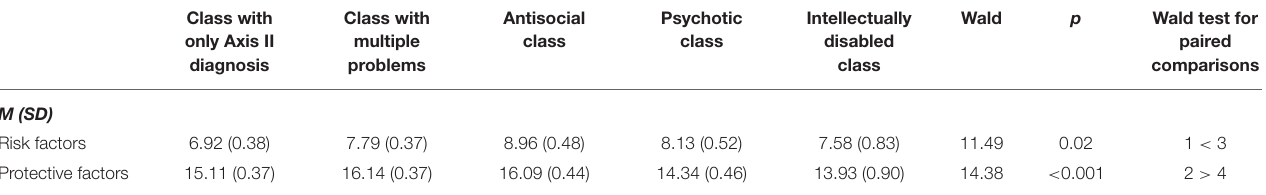
TABLE 6 | Class-specific means of risk and protective factors at scale level.